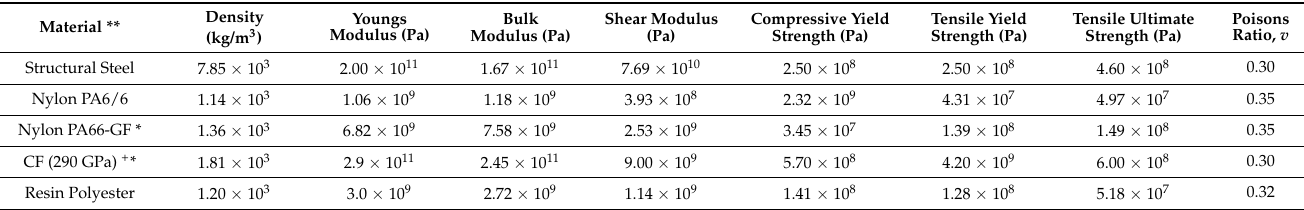
Table 2. Table 1. Material properties for composites and steel. Table 1. Material properties for composites and steel .